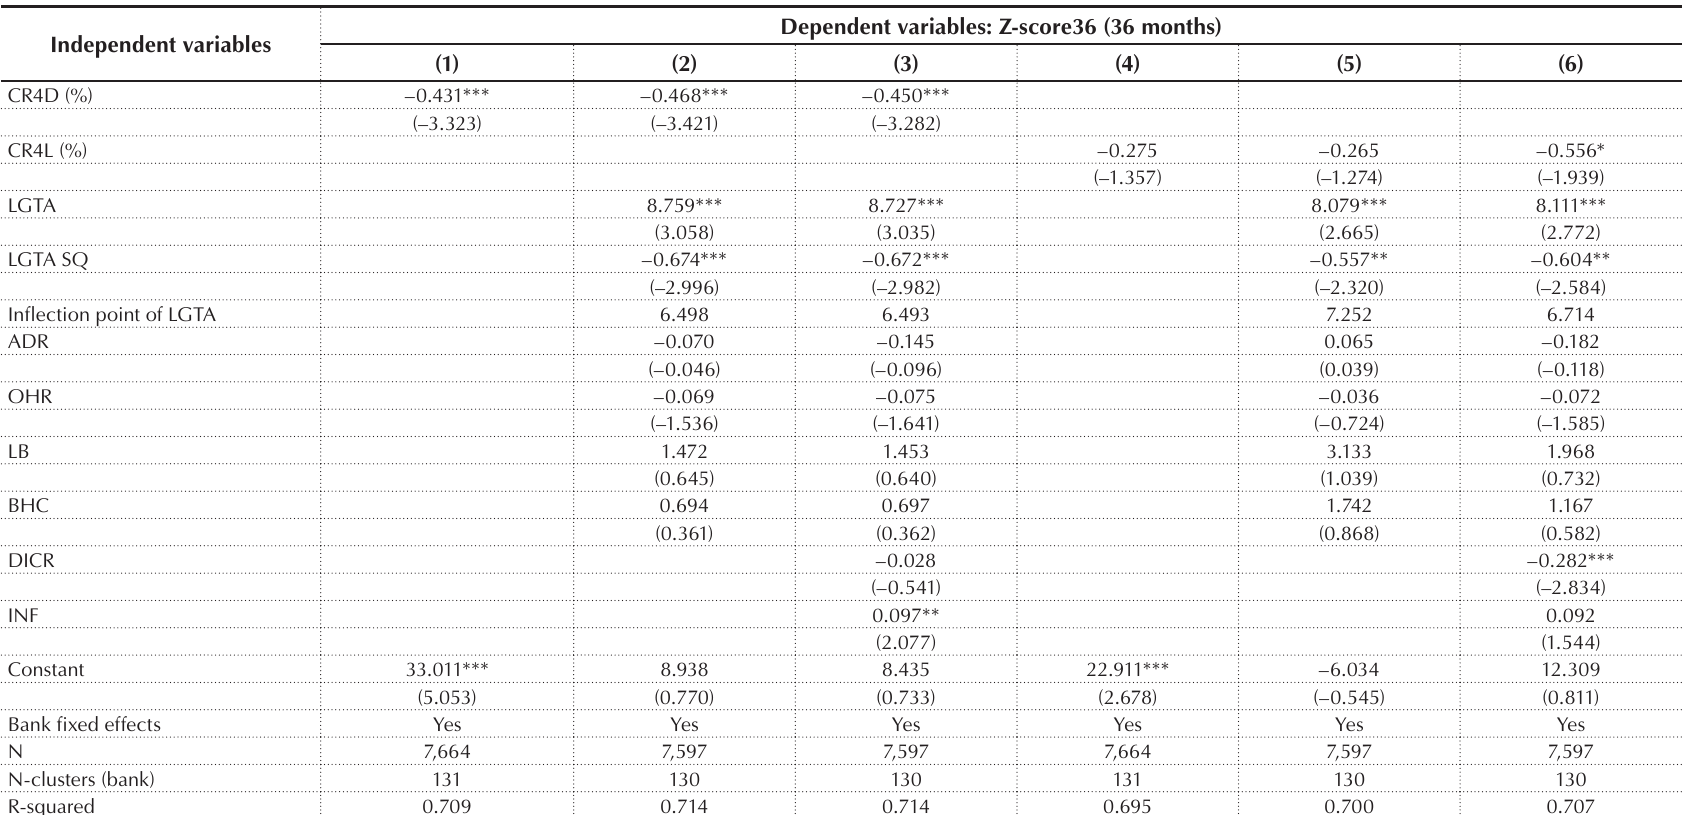
Panel B. Alternative competition measures